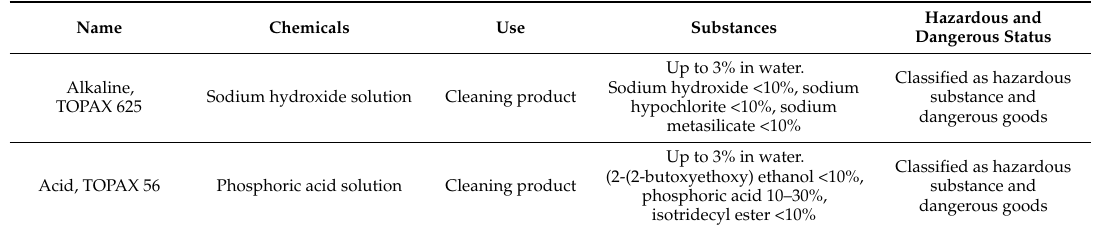
Table 4. Specification and status of chemicals in use at an Australian